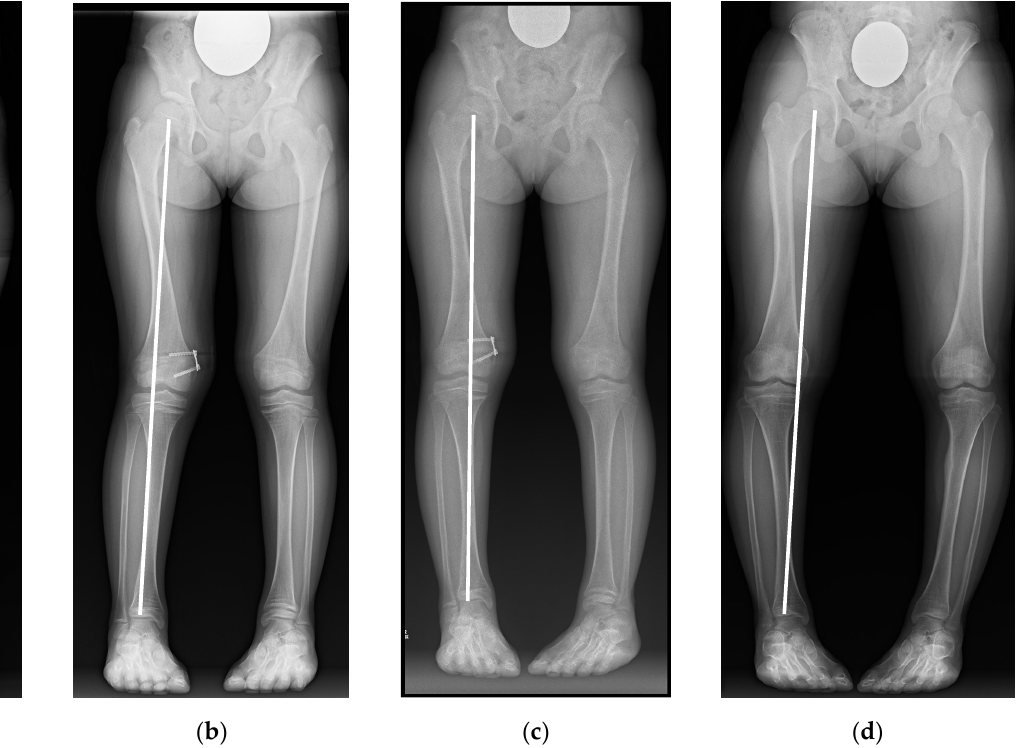
Figure 3. A case with varied deformities. White lines are the mechanical axis. ( a ) Preoperative; valgus deformity of the right lower limb and leg length discrepancy (LLD) ( b ) 1 year after guided growth surgery; valgus deformity and LLD was improving. ( c ) After deformity correction; only one side of guided growth surgery led to correction of both valgus knee deformity and leg length discrepancy ( d ) 1 year after implant removal; varus deformity of the corrected right lower limb emerged.